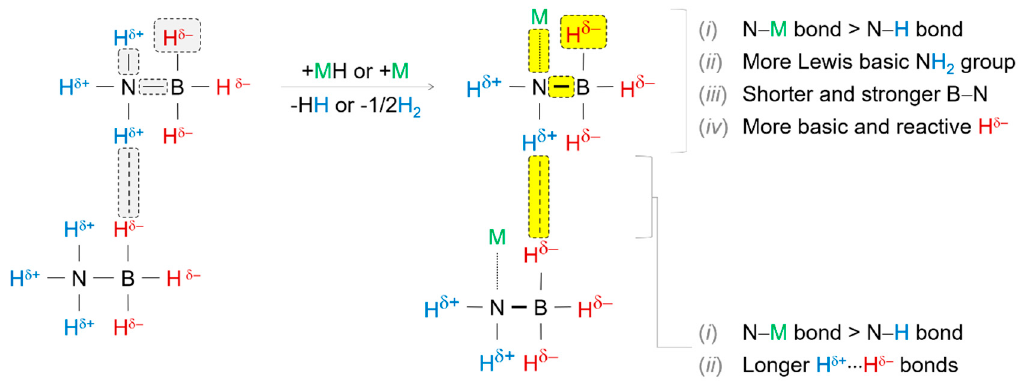
Figure 19. Better dehydrogenation properties in amidoboranes (versus ammonia borane) owing to changes in chemical bonding, both intramolecular (e.g., B − N bond) and intermolecular (i.e., dihydrogen N − H δ + ⋅⋅⋅ H δ− − B bonds).